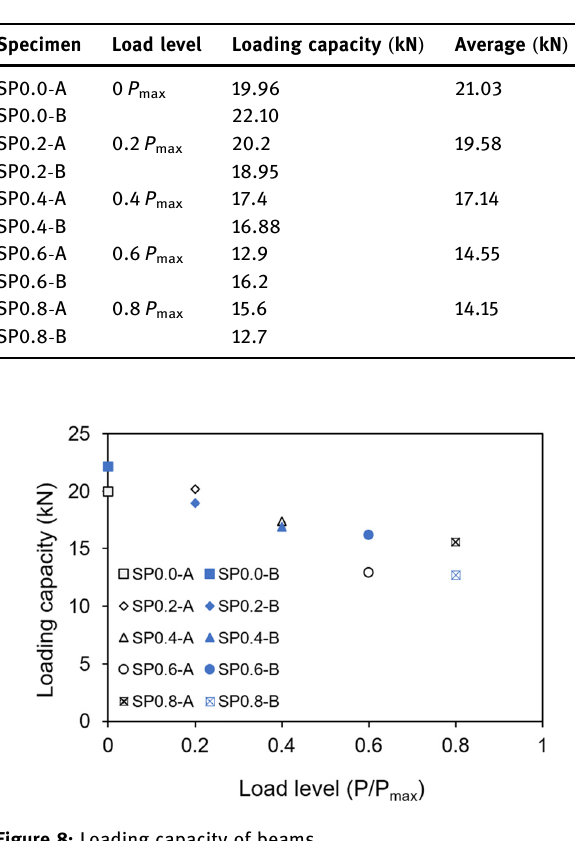
Table 4: Loading capacity of beams with corroded reinforcement